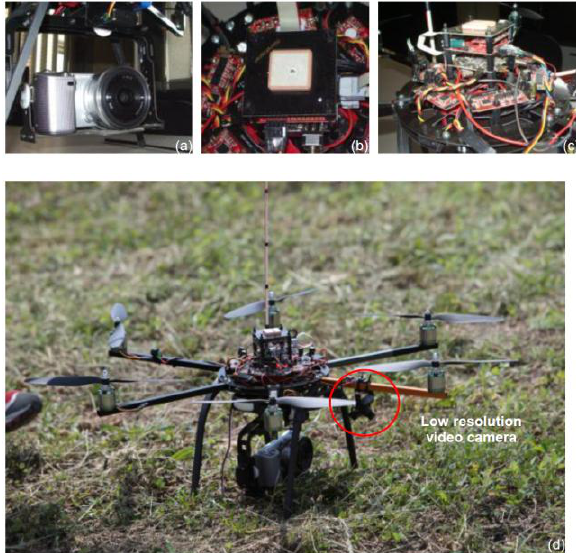
Figure 2. The digital camera Sony NEX-5 (a), The Ublox GPS receiver antenna (b), the electronic control unit (c). In (d) from the highest to the lowest part: BL, FC, NC, MK3Mag, MKGPS, and the Hexakopter by Mikrokopter